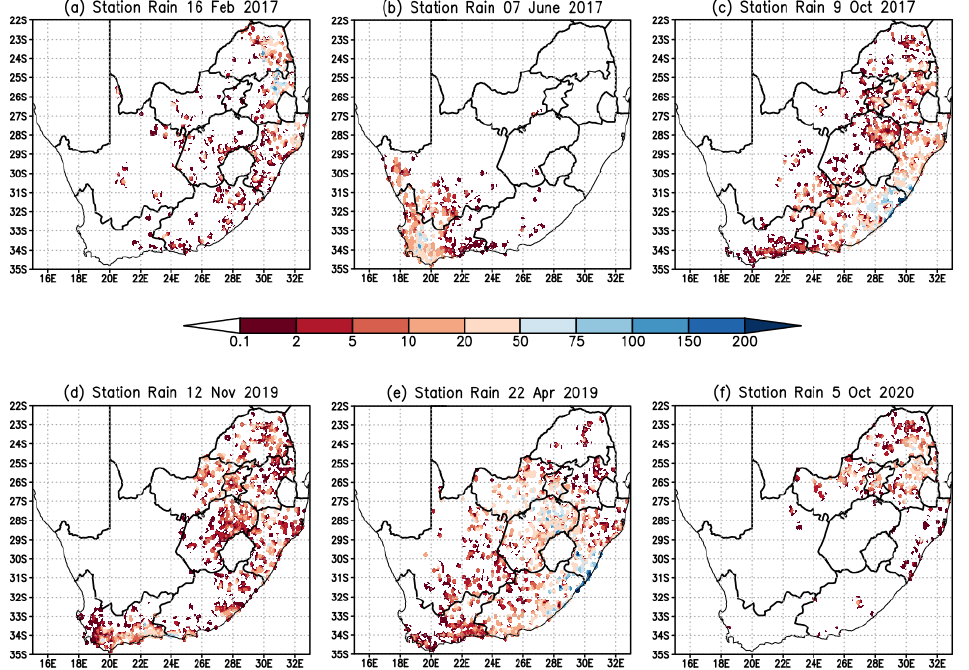
Figure 2. Observed twenty-four rainfall (mm) on ( a ) 16 February 2017, ( b ) 7 June 2017, ( c ) 9 October